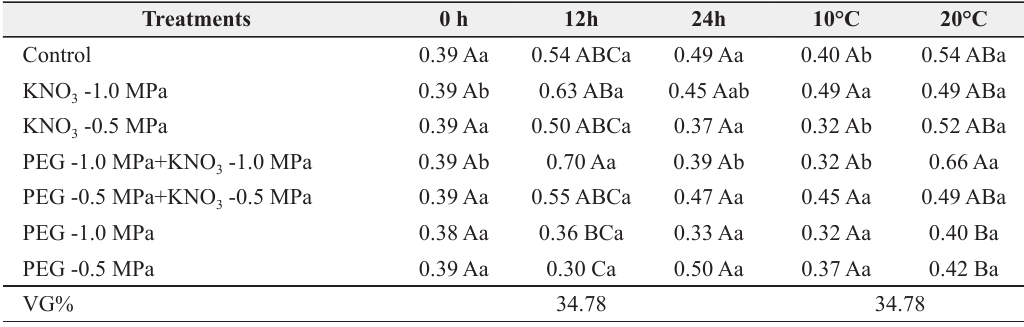
Shoot/root ratio (SRR) of Myracrodruon urundeuva Allemão seedlings due to different periods